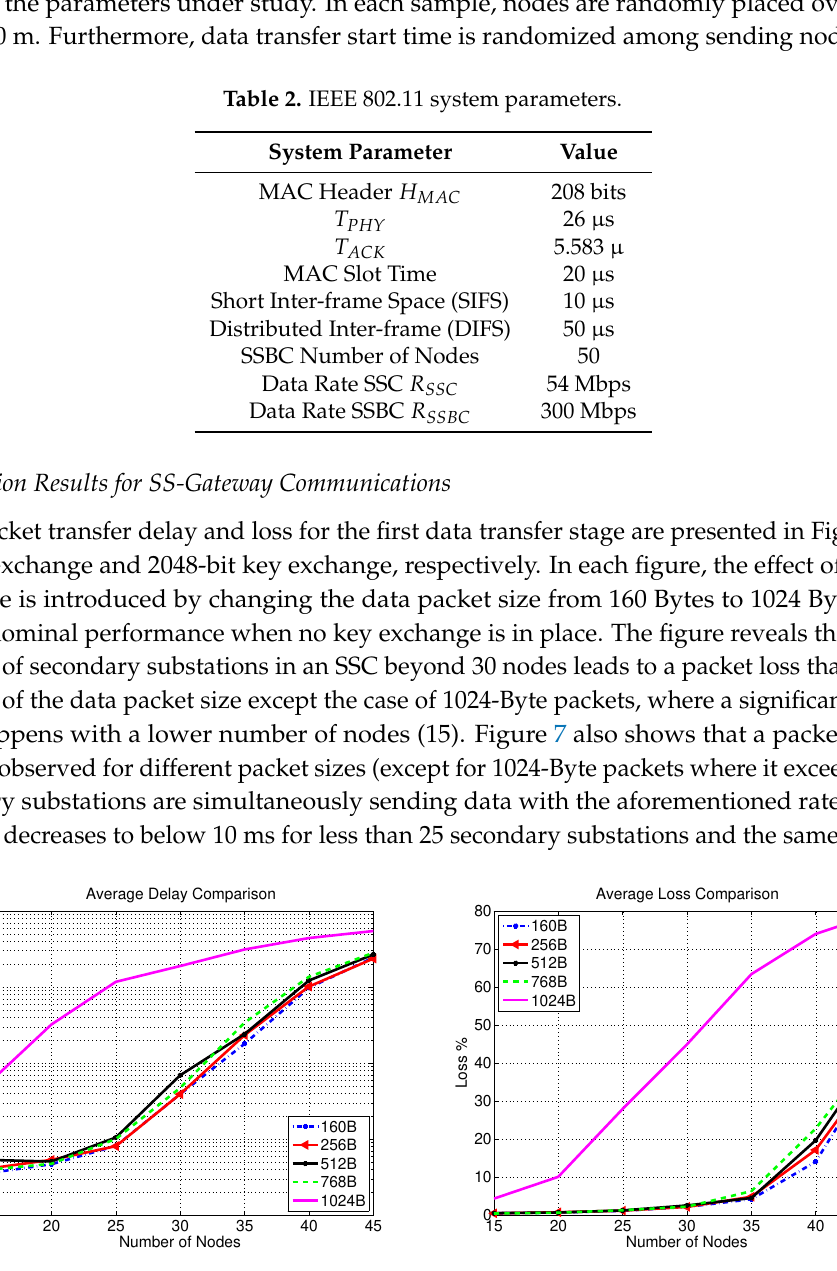
Figure 7. SS-Gateway communication performance (no key